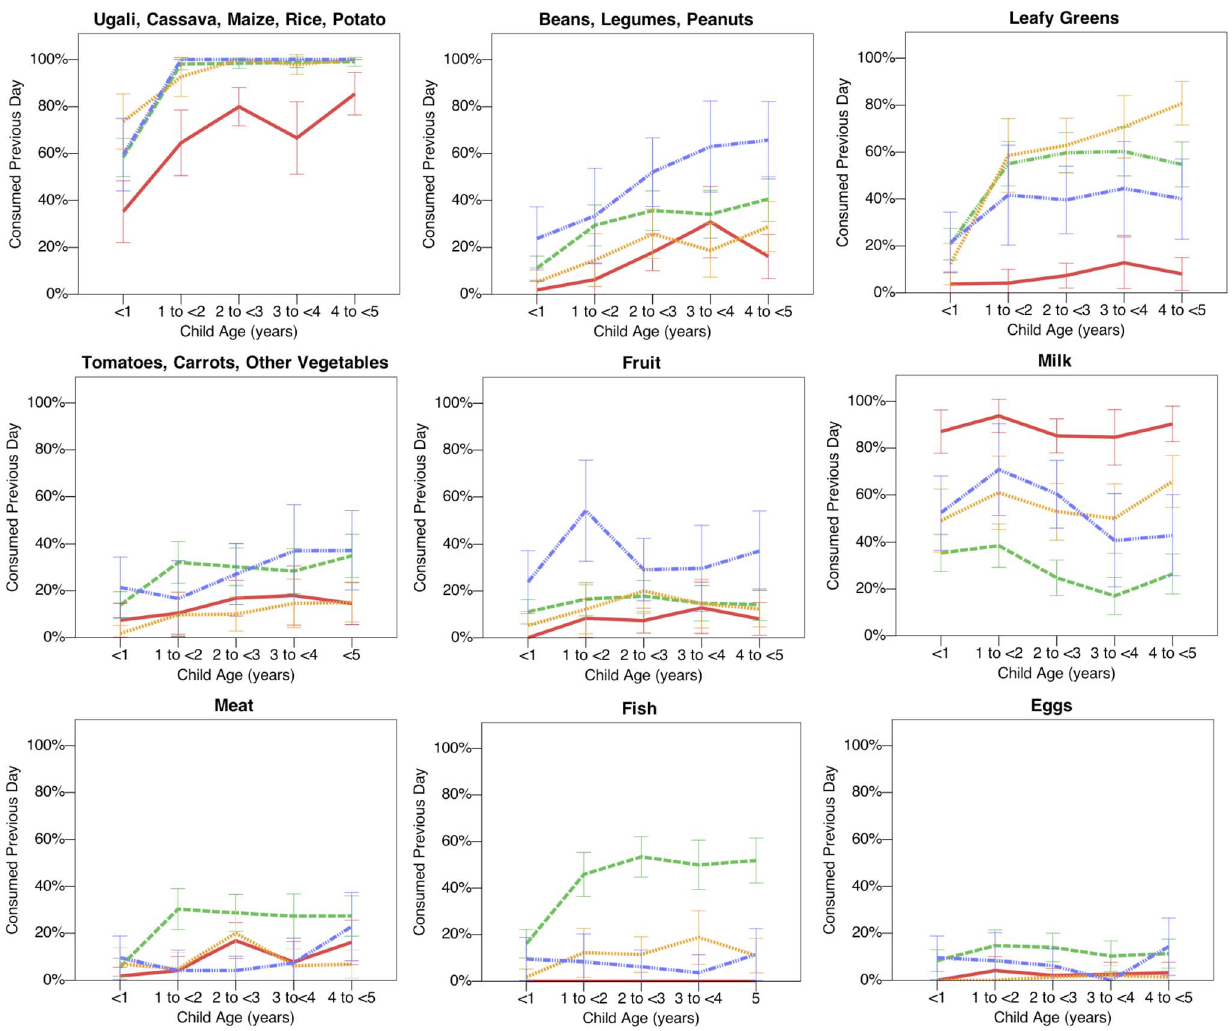
Figure3. Child Diet by Age and Ethnicity. Dietary analyses reveal substantial ethnic variation in reported child diet. Red solid line = Maasai children; orange dotted line = Rangi children; green dashed line = Sukuma children; blue dotted and dashed line = Meru children. Data plotted only for the 31 villages sampled outside of the hunger season (n=1903 children), to avoid confounding between ethnicity and season of sampling. 95% confidence intervals calculated using normal approximation. See File S5 for multilevel logistic regression models predicting food consumption for all children and villages adjusted for child age, child sex, hunger season and a random effect for village.